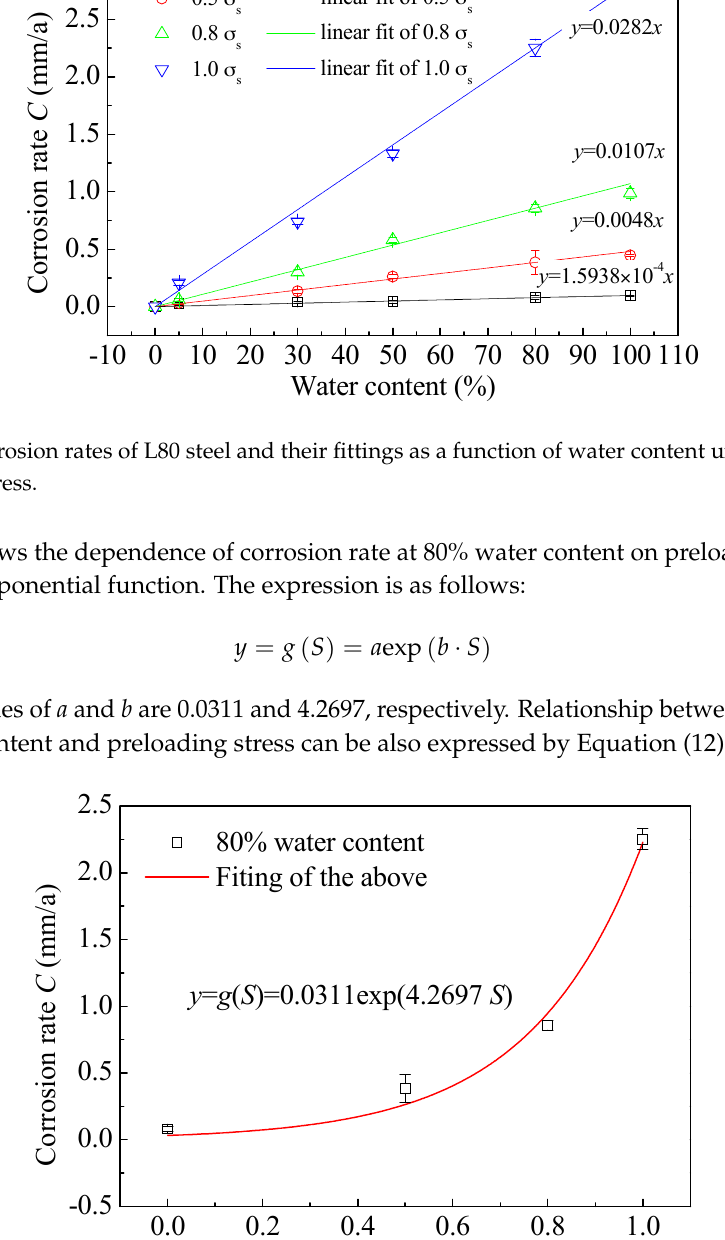
Figure 9. Dependence of corrosion rate of L80 steel at 80% water content on preloading stress.